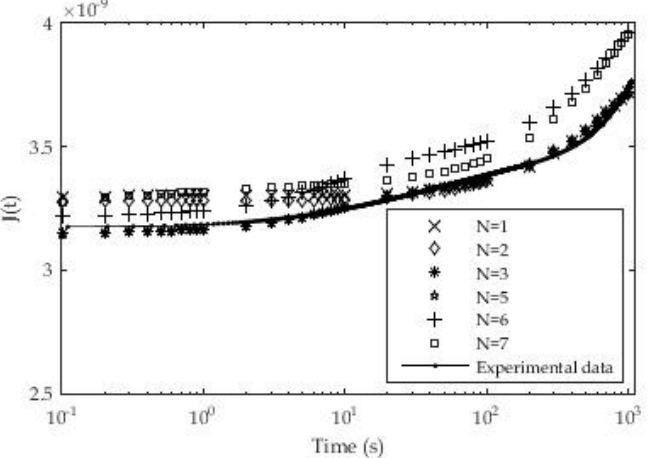
Figure 7. Experimental and approximate values of creep modulus (PLA, d 1 = 0.09 mm). Table 2. Average deviation between experimental and fitted data (PLA, d 1 = 0.09 mm).